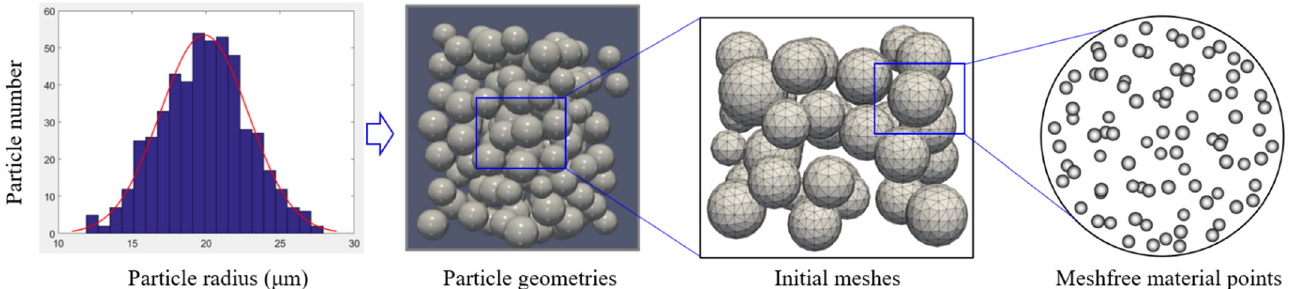
Figure 10. The geometry modeling of powder particles with meshfree discrete.